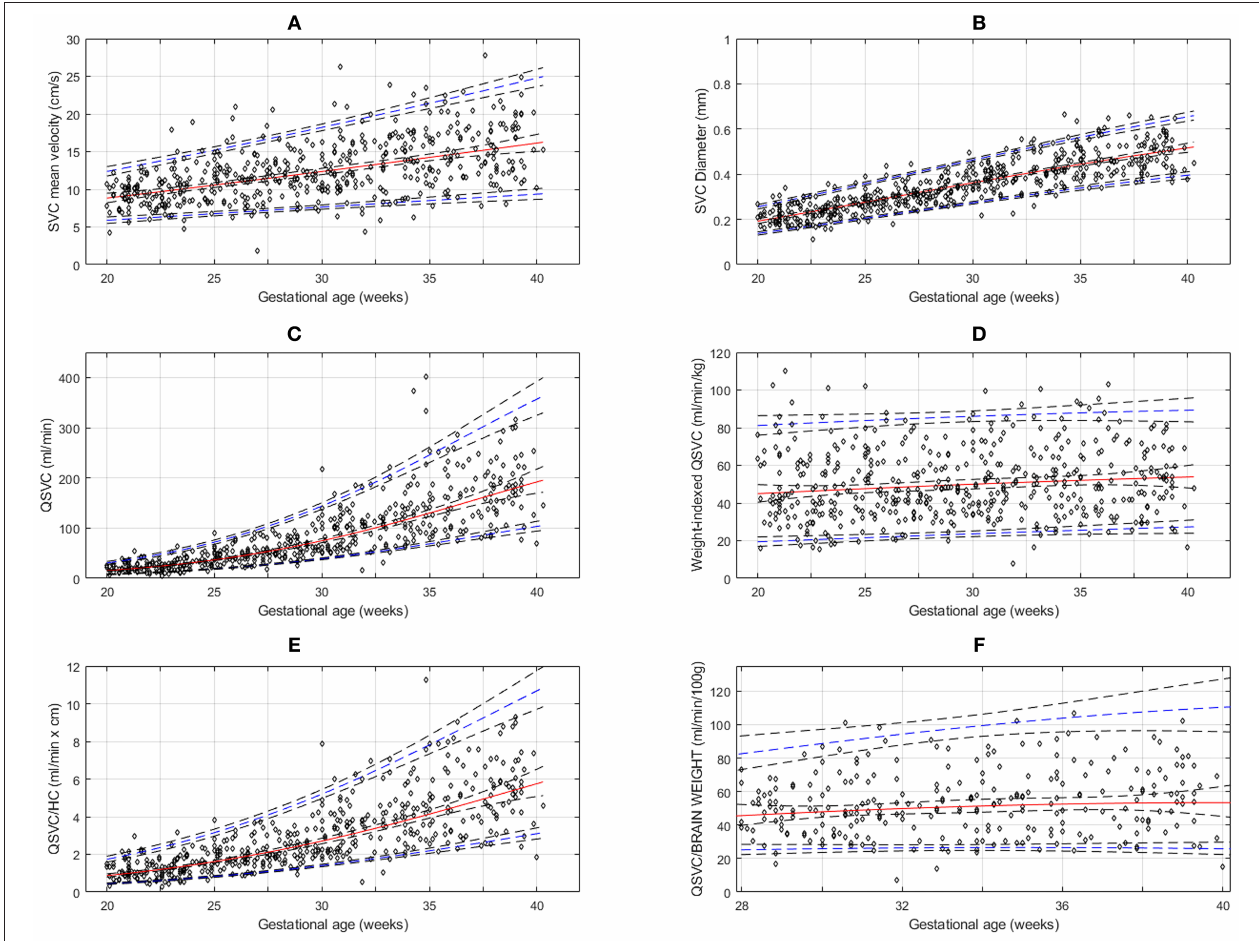
FIGURE 2 | Reference charts for fetal superior vena cava (SVC): (A) mean velocity, (B) diameter, (C) volume blood flow (Q SVC ), (D) weight-indexed Q SVC , (E) volume blood flow normalized by head circumference (Qsvc/HC) at 20-40 weeks of gestation, and (F) volume blood flow (Q SVC ) normalized by estimated fetal brain weight at 28–40 weeks of gestation. The solid red line represents the 50th percentile, the blue lines represent the 5 and 95th percentiles and the interrupted black lines represent their respective 95% confidence